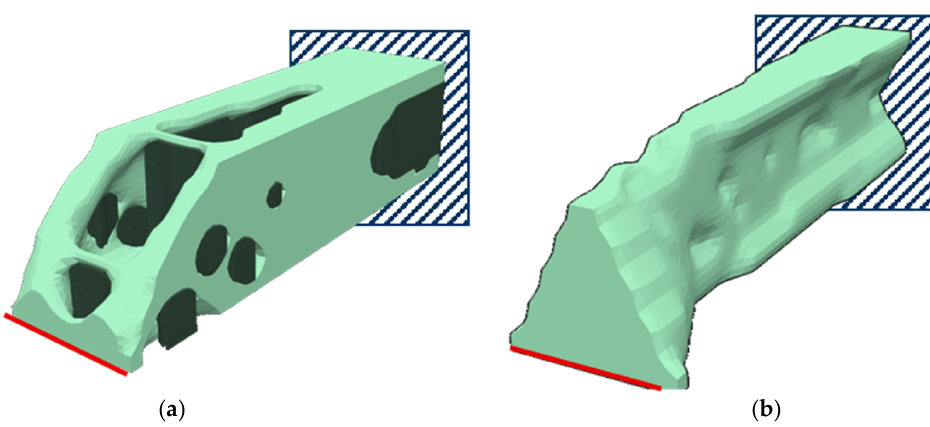
Figure 8. Comparison of the reference design proposal ( a ) and the design proposal with the highest effective material usage ( b ) for the cantilever application example. The support-material is displayed in dark green, while constraints are visualized in dark blue and loaded areas in red.